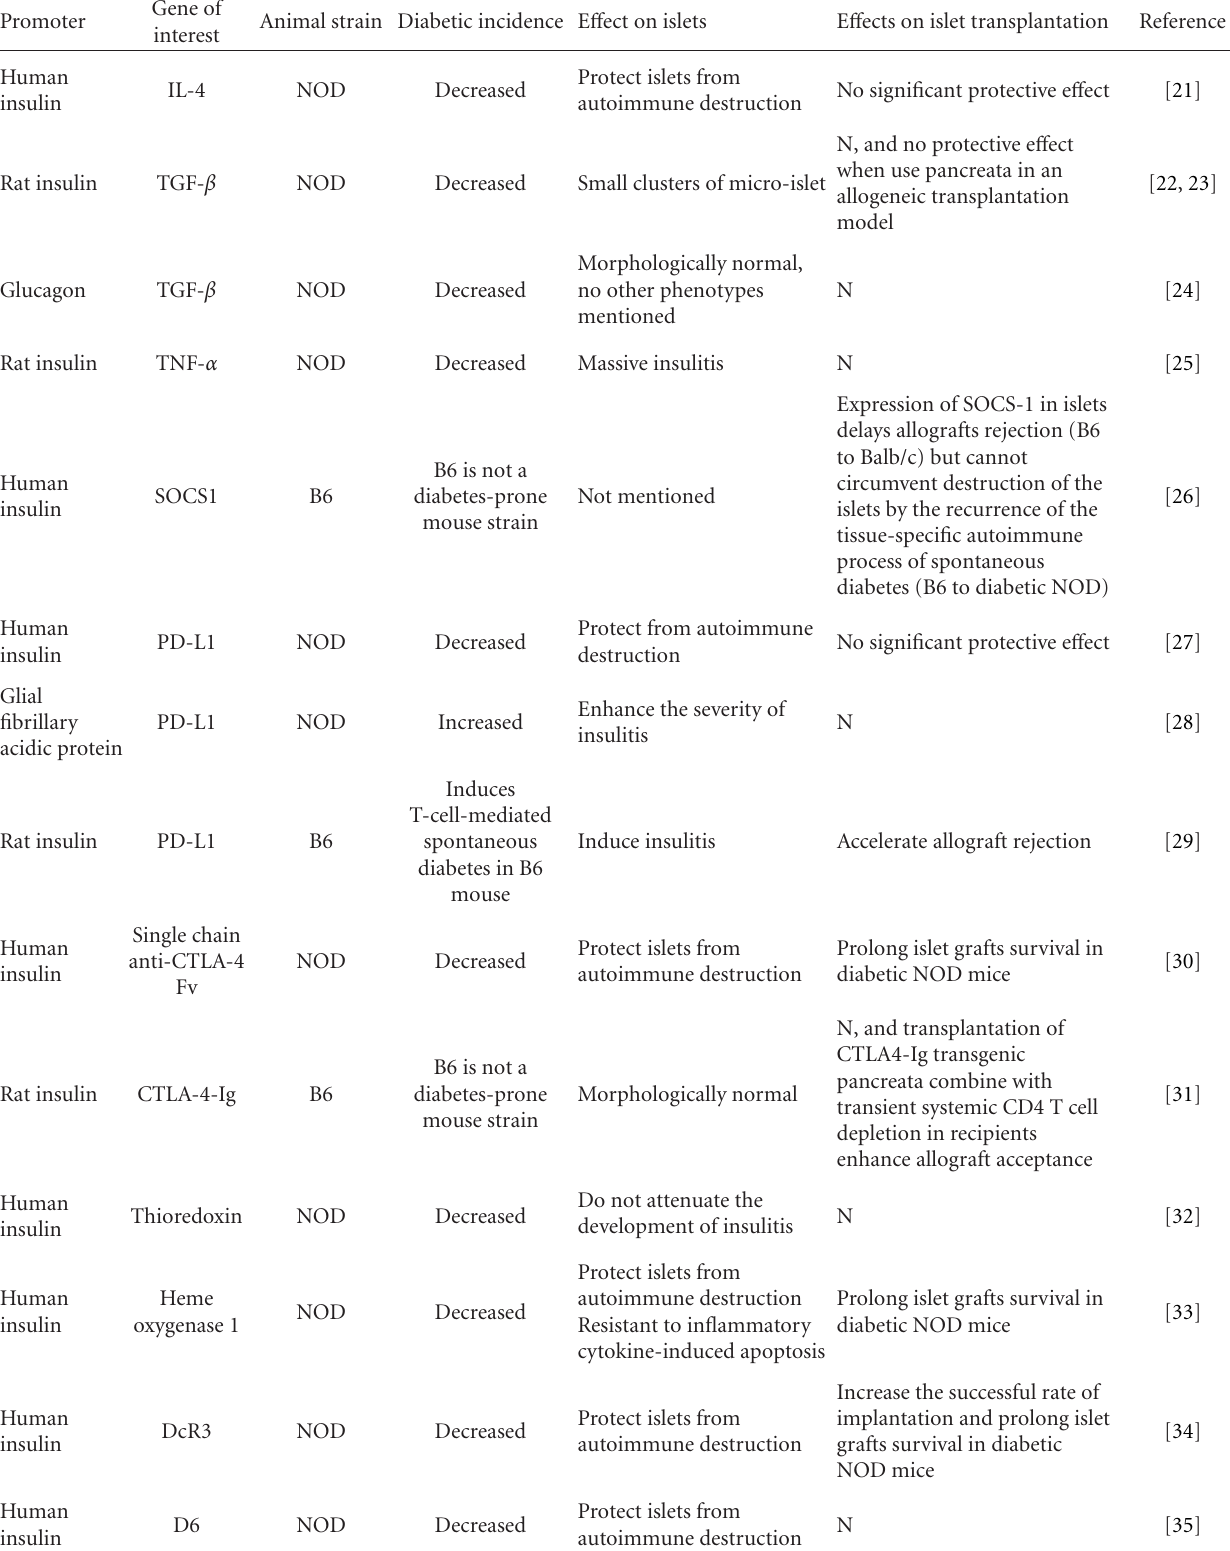
Table 1: Transgenic overexpression of regulatory genes in the islets and their e ff ects on islet transplantation.